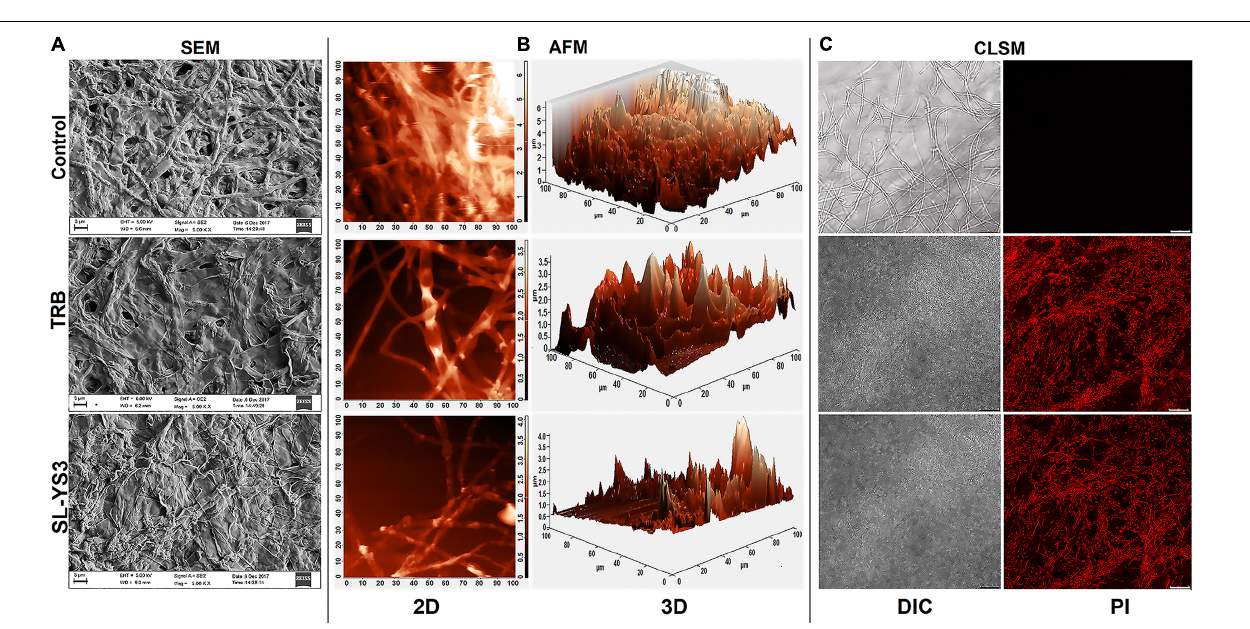
FIGURE 5 | Microscopic observation of the effect of the sophorolipid produced by R. babjevae YS3 (SL-YS3) on mycelial integrity of T. mentagrophytes . (A) Scanning electron micrographs of the mycelial damage induced by SL-YS3 and terbinafine (TRB) treatment. Magnification = 5000 × , scale bar = 2 µ m. (B) Atomic force microscopic images to visualize the topographical changes induced by SL-YS3 and TRB treatment (1 mg ml − 1 ) in comparison to the untreated control mycelia. Images were acquired after 24 h of treatment. Total scanning area for the images are 100 µ m × 100 µ m. (C) Confocal microscopic images to determine the uptake of propidium iodide (PI) in the mycelia treated with SL-YS3 and TRB at a concentration of 1 mg ml − 1 (w/v) as compared to the untreated mycelia. Scale bar = 25 µ m.